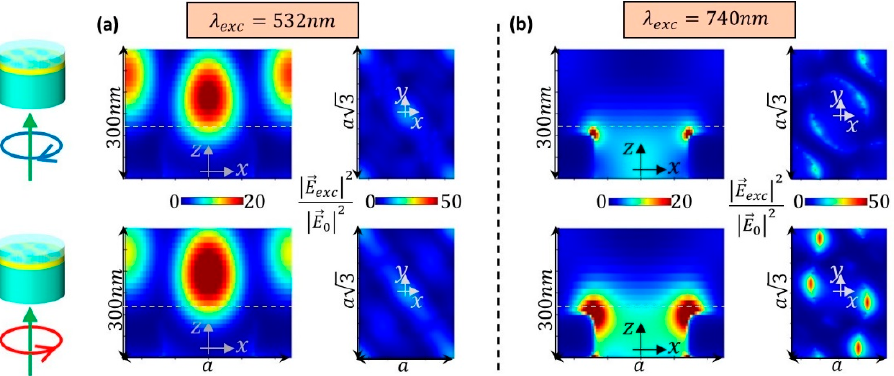
Figure 7. Passive simulations of the electric field intensity enhancement for the Au-ENHA, when its excited with RCP (top), or LCP (light) from the bottom. We plot normalized electric field intensity in two-unit cell cross-sections, detected by xz-monitor (centered at y = 0 nm), and xy-monitor (situated at z = 120 nm), at ( a ) 532 nm, and ( b ) 740 nm.